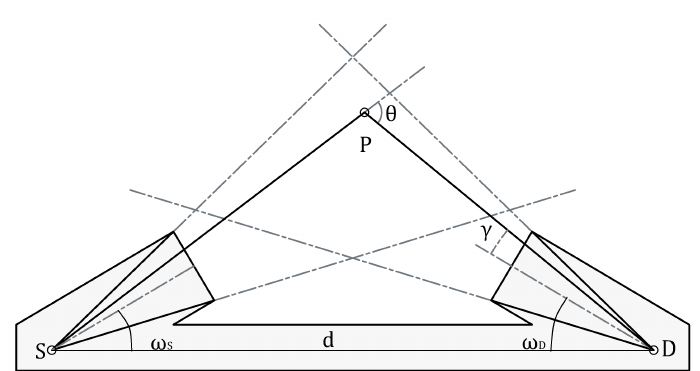
Figure 3. Schema showing the geometry of the problem. S: Source. D: Detector. P: Point where is located the scattering element. θ : Scattering angle. γ : Angle between optical axis and P ( γ S for S and γ D for D). ω : angle between SD and the optical